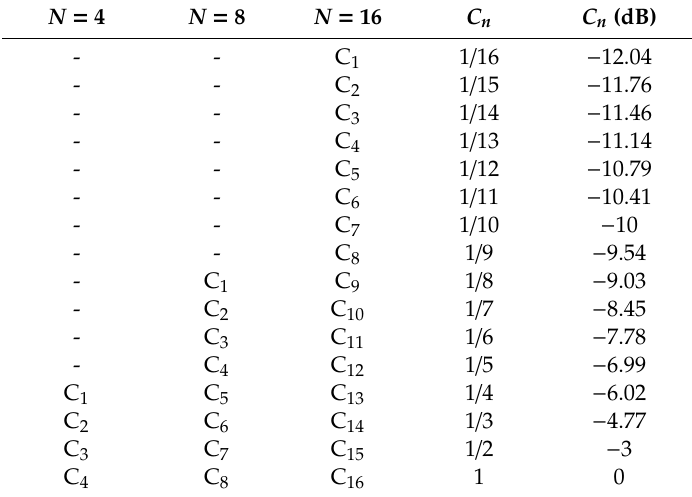
Table 1. Calculated values of power coupling factors for values of the overall tap number: N = 4, 8, and 16. N = 4 N = 8 N = 16 C n C n (dB) - - C 1 1 / 16 − 12.04 - - C 2 1 / 15 − 11.76 - - C 3 1 / 14 − 11.46 - - − 11.14 - - - - 1 / 10 − 10 -